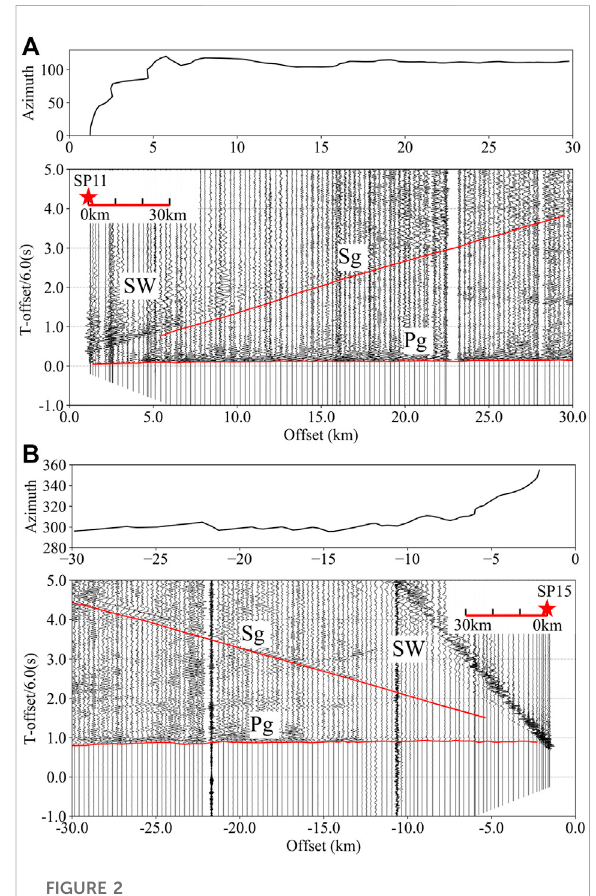
FIGURE 2 Azimuths of the source-receiver raypaths and seismic record sections plotted at a reduction velocity of 6.0 km/s. In the upper right corner of the seismic record sections, the red stars represent the sources, and the seismic record sections are recorded by the seismographs on thered line. Pg and Sg are the P- and S-wave refractions respectively, and the picked traveltimes are marked by the red lines. SW represents the surface wave. (A) Azimuths of the SP11 source-receiver raypaths and the corresponding seismic record section. (B) Azimuths of the SP15 source-receiver raypaths and the corresponding seismic record